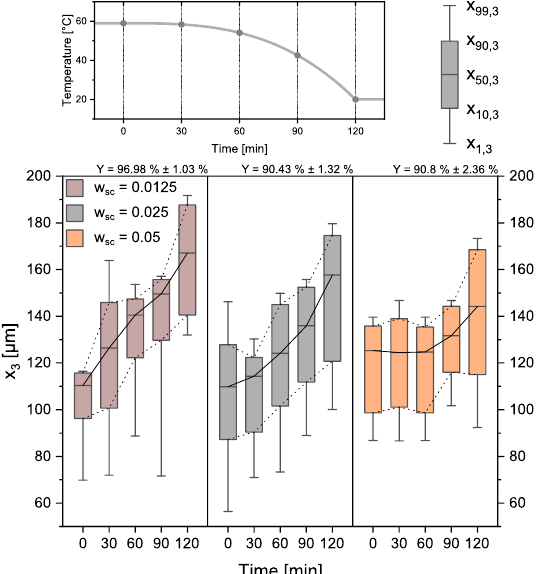
Figure 10. CSDs for three different seed crystal amounts (0.0125g · g − 1 The temperature profile and sampling times can be seen in the top panel. Respecting yields are given above the Boxplots. Progressive profile, process time t process = 120min, seed sieve size: